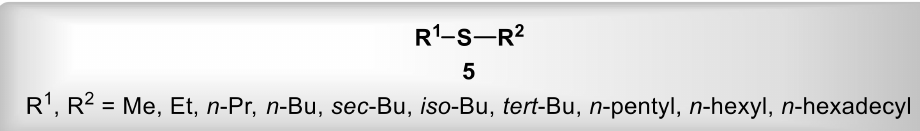
Figure 2. Structures of dialkyl sulphides 5 used in the